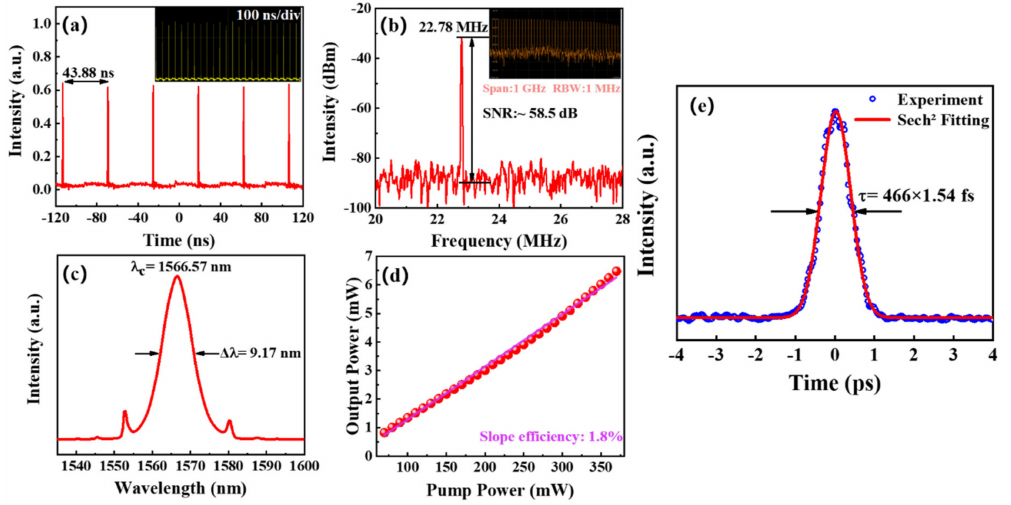
Figure 7. Ultrafast laser output characterizations of Er 3+ -doped fiber laser (EDFL) based on Ti 3 C 2 T x QDs tapered fiber SA. ( a ) Mode-locking pulse trains. ( b ) The RF optical spectrum at the fundamental frequency. ( c ) Mode-locking optical spectrum. ( d ) The output power varies with pump power. ( e ) Autocorrelation trace with a sech 2